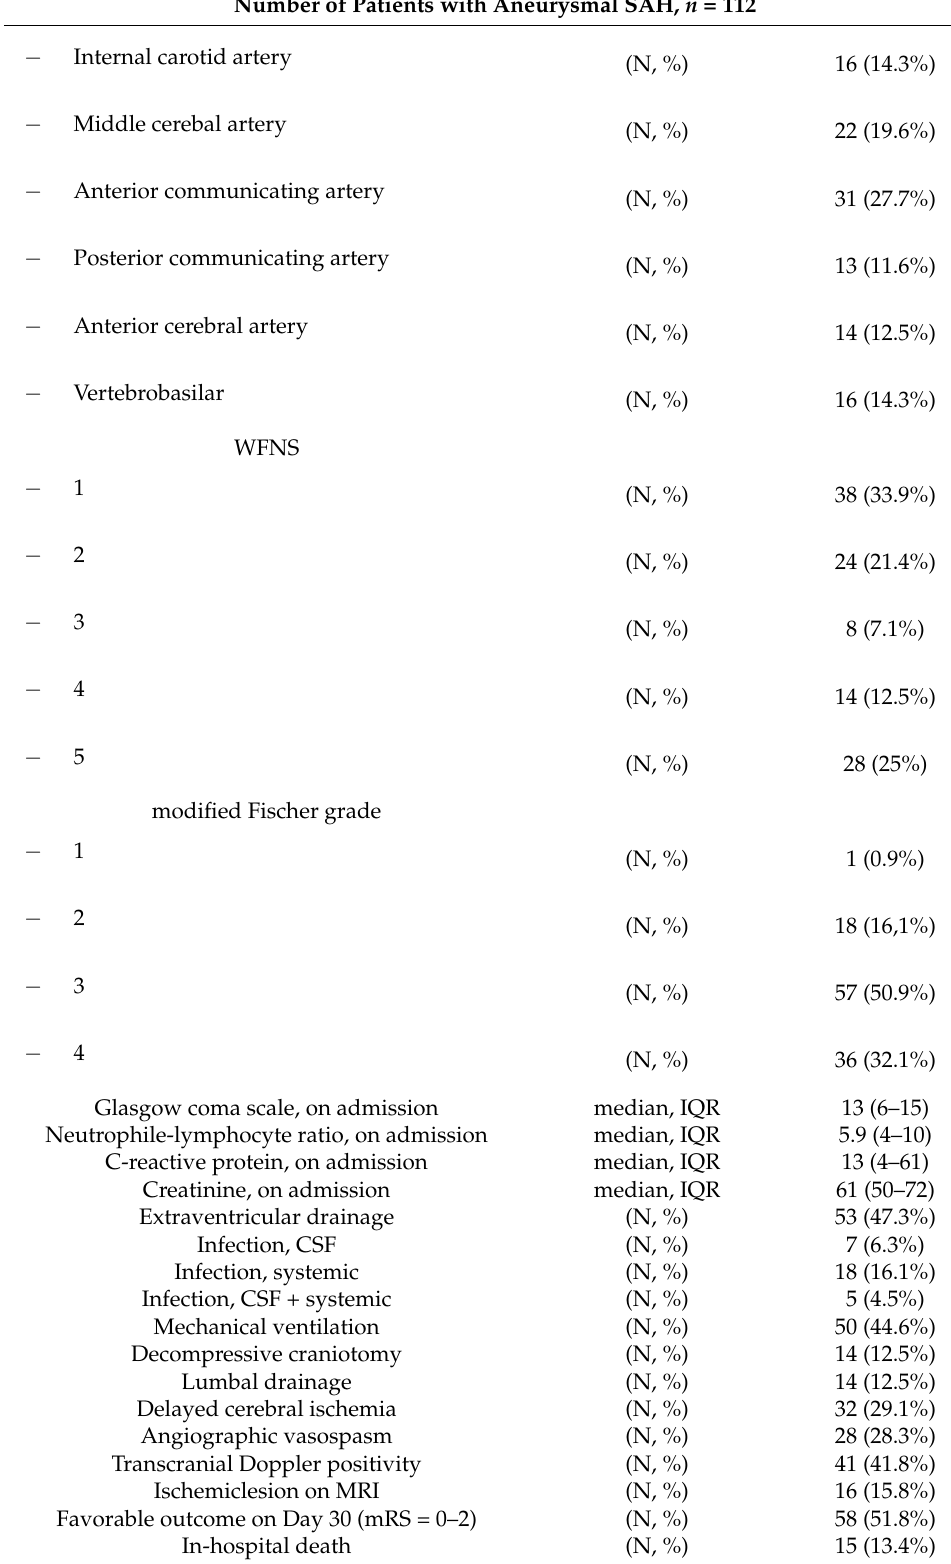
Table 1. Cont . Number of Patients with Aneurysmal SAH, n =